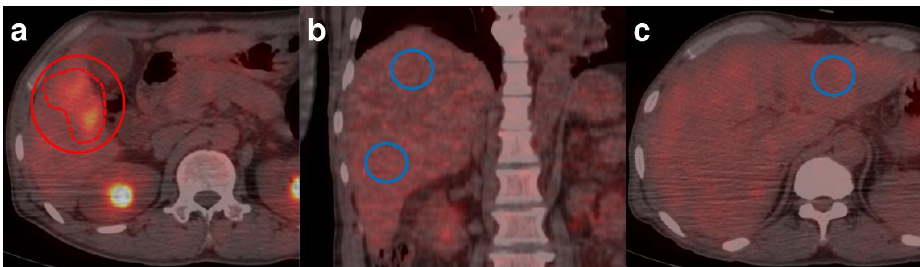
Figure 2. Measurement methods on 18 F-fluorodeoxyglucose positron emission tomography/computed tomography images. ( a ) A spheric volume of interest (VOI) was carefully drawn to include the entire tumor (solid line), and the tumor contour (dashed line) was automatically drawn using a specific threshold of 41% of the maximum value. Then the maximum standardized uptake value (SUV) normalized by total body weight and the maximum SUV normalized by lean body mass was obtained. ( b , c ). For the background-liver regions, three spherical VOIs (14 cm 3 ) of 30-mm diameter (blue circle) were drawn at 3 sites of the liver, 2 above and below the right portal vein, and 1 at the middle level of the left lobe, in a region where the tumor was not detected on other